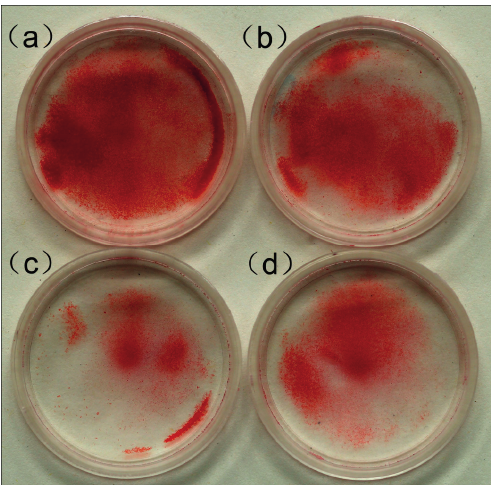
Figure 3. The alizarin red staining of the calcified nodules of cementoblasts after 14 days cultured in various concentrations of MWCNT-COOH: ( a ) 5 µg/mL; ( b ) 15 µg/mL; ( c ) 25 µg/mL; and ( d )